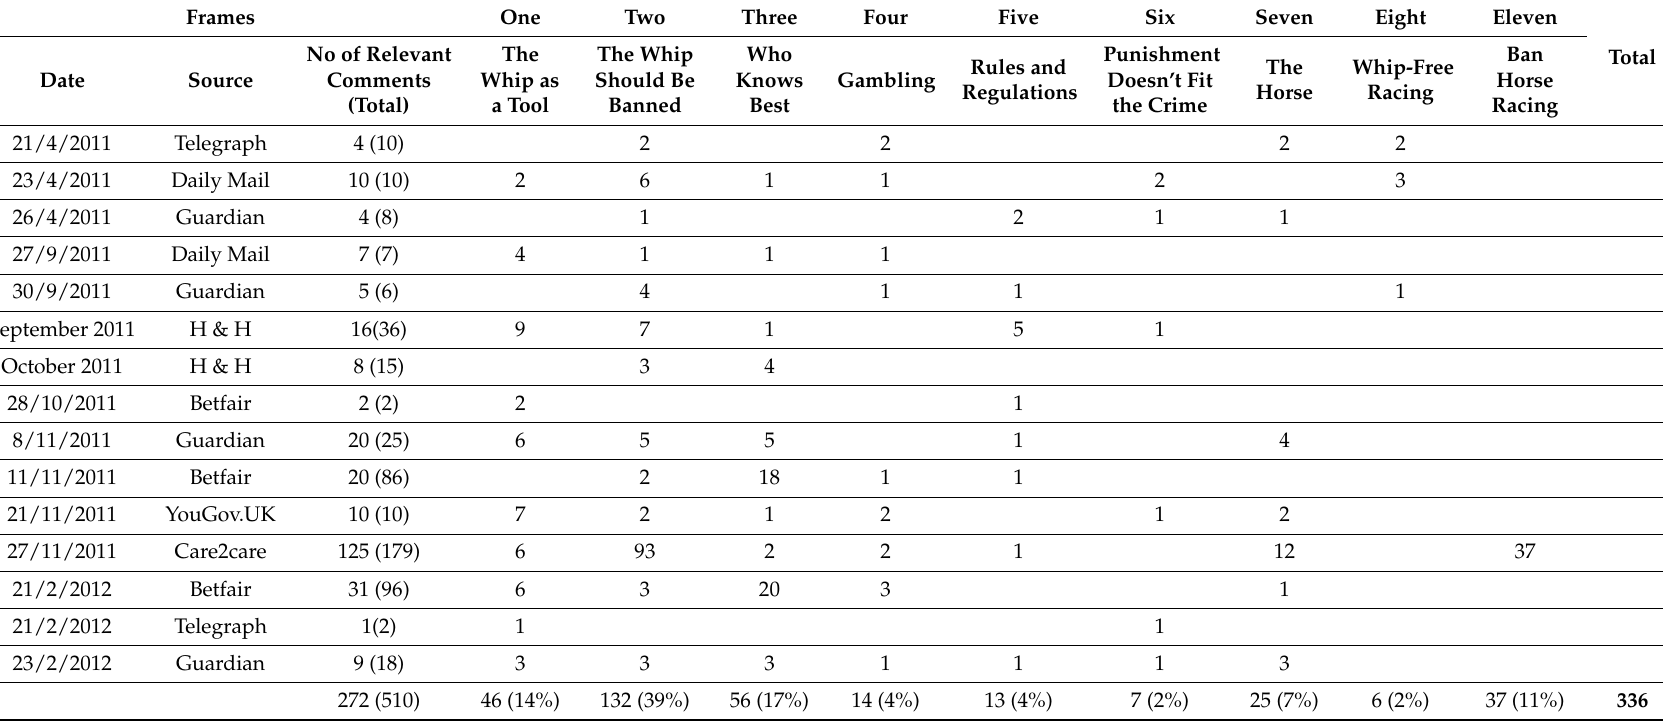
Table 5. UK: Online readers’ comments April 2011–February 2012 (2015 not noted as only ten comments from one